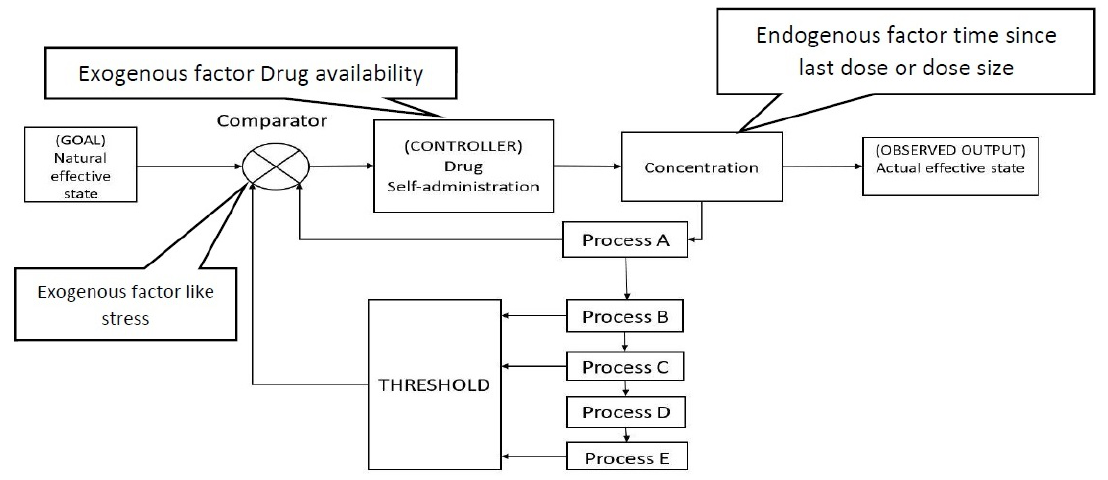
Figure 1. Control theory model of smoking re-drawn following